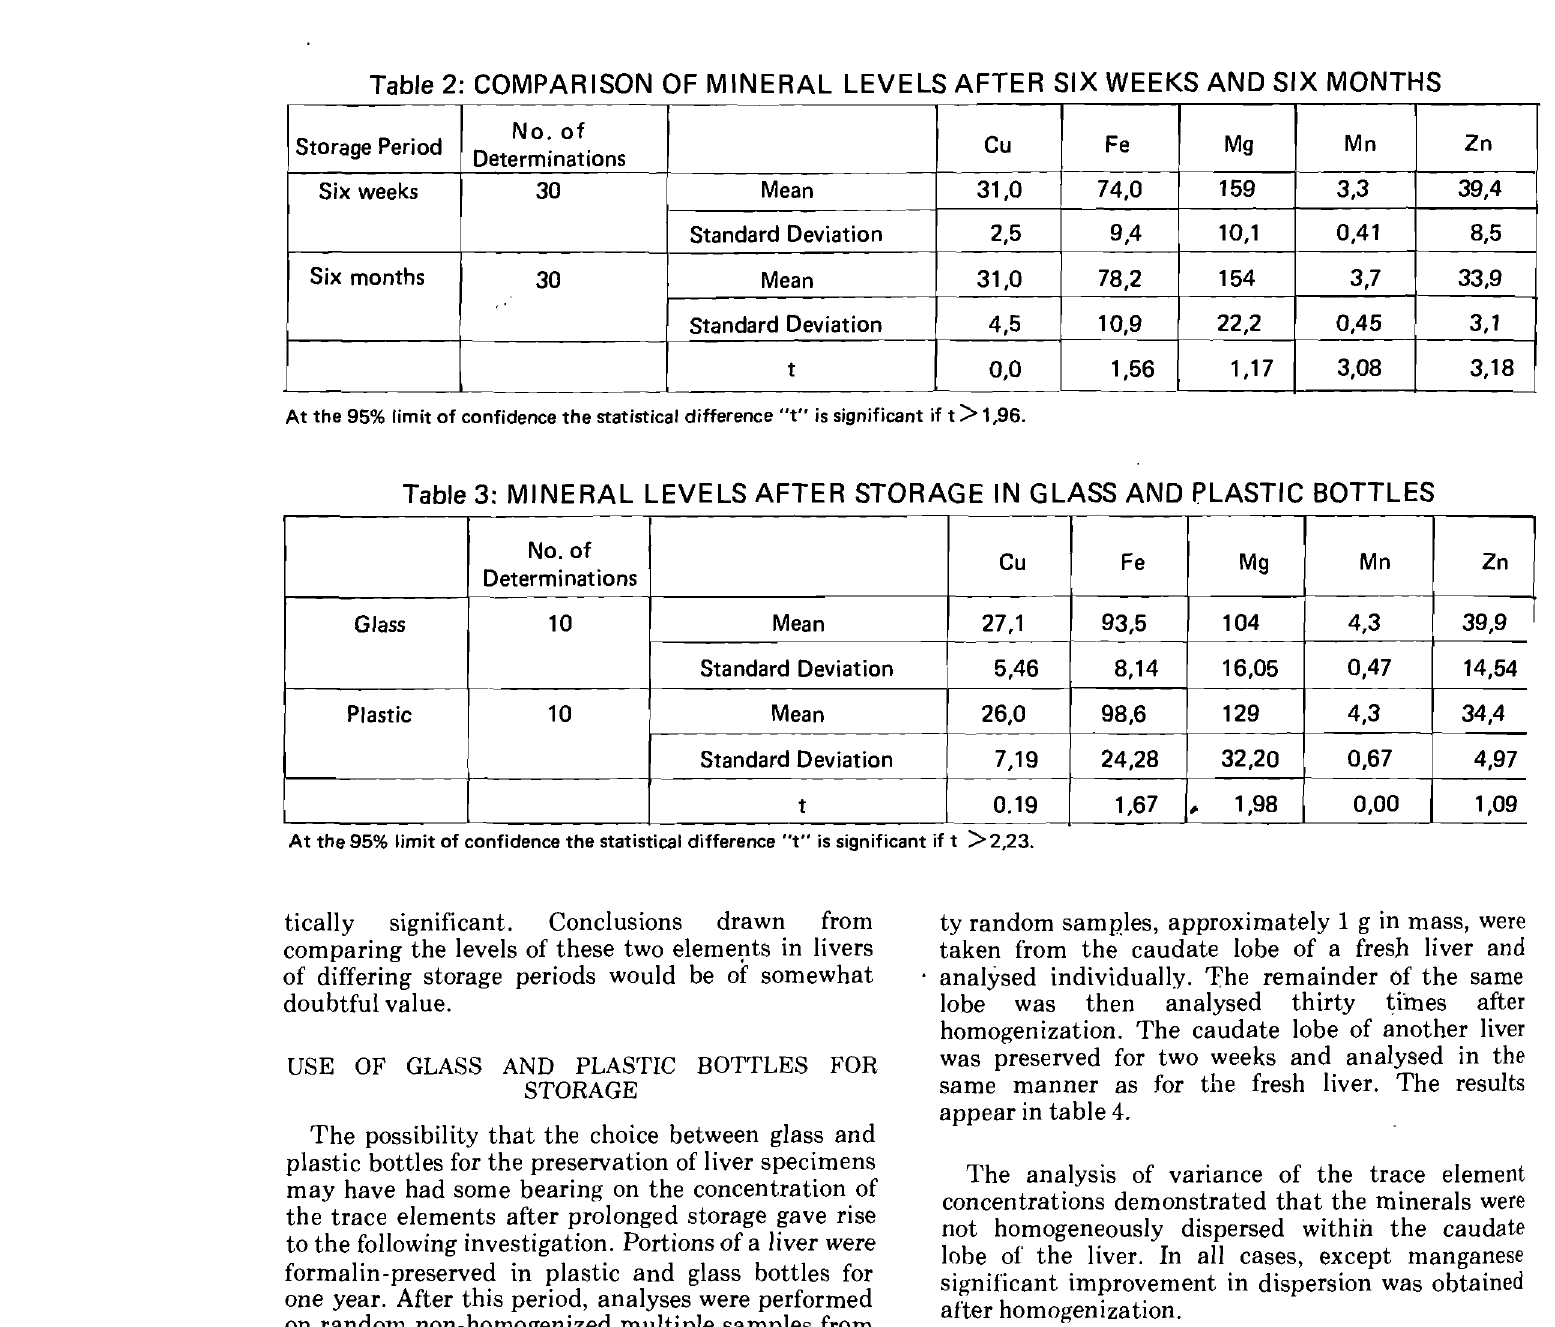
Table 3: MINERAL LEVELS AFTER STORAGE IN GLASS AND PLASTIC BOTTLES No. of